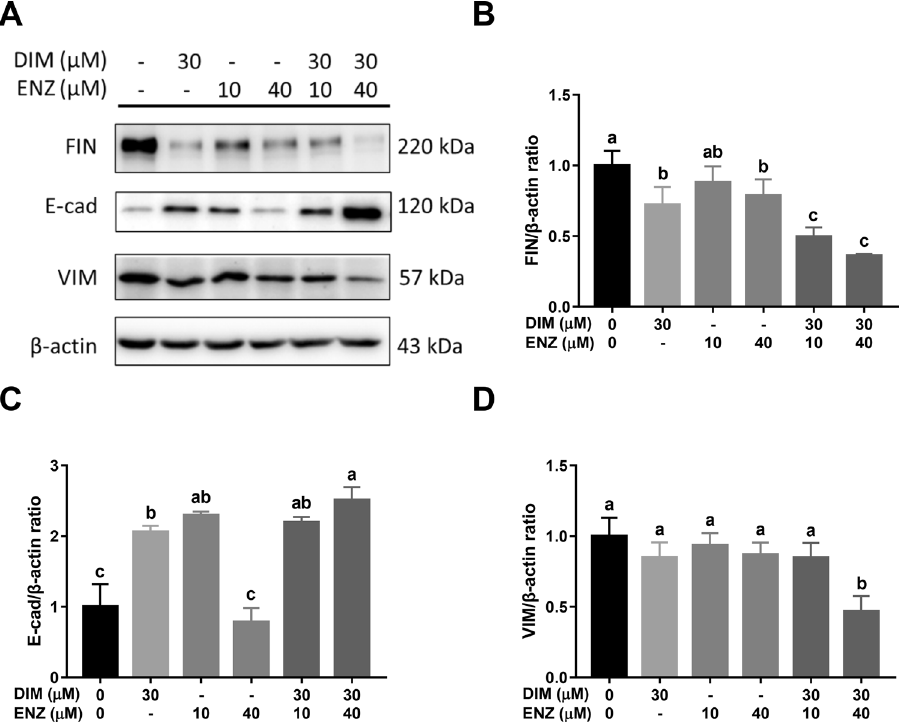
Figure 10. DIM and ENZ treatment alter EMT-related protein expressions in 22Rv1 cells at 72 h. Representative western blot image ( A ); quantitative results for FIN ( B ), E-cad ( C ), and VIM ( D ). DIM 3,3 ′ -diindolylmethane; ENZ enzalutamide; VIM Vimentin; FIN Fibronectin; E-cad E-cadherin. Values are presented as means ± SD. a,b,c Bars without the same letters at the top indicate statistically-significant differences between treatments when compared with each other (one-way ANOVA, Duncan’s new multiple range test, p <